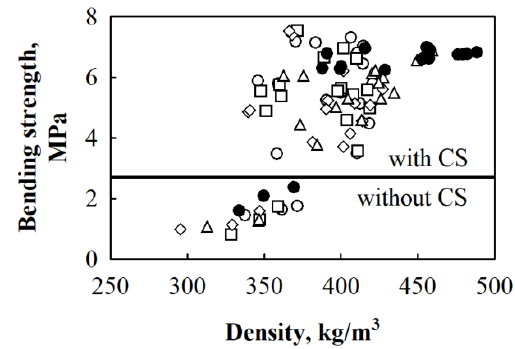
Figure 6. Relationship between bending strength and density where designated dots present experimental data for BcB from HS fraction, mm: ○ — 5/10; □— 10/20; ◊— 2.5/20; Δ— 2.5/5; ●— shredded HS; ( ─── ) — separation line for results obtained from specimens with and without CS binder.